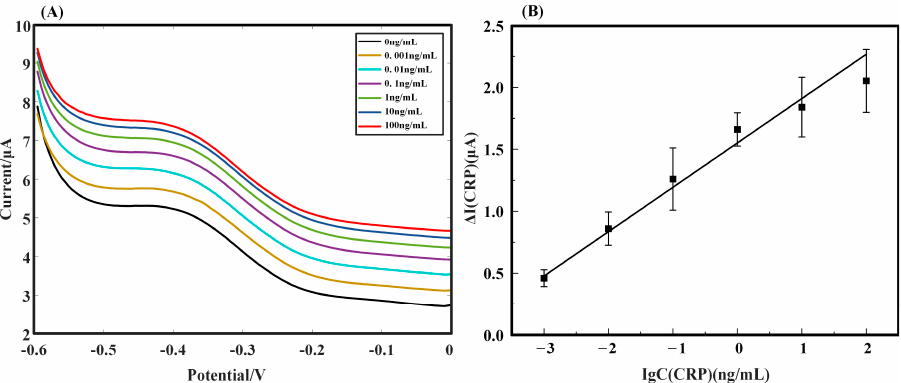
Figure 3. ( A ) Voltage-current diagram of CRP solutions from 0.001 ng/mL to 100 ng/mL using the DPV method. ( B ) The curve of peak currents for each concentration of CRP fitted to the difference between the 0 ng/mL CRP solution and the logarithm of the CRP concentration (n - 3).